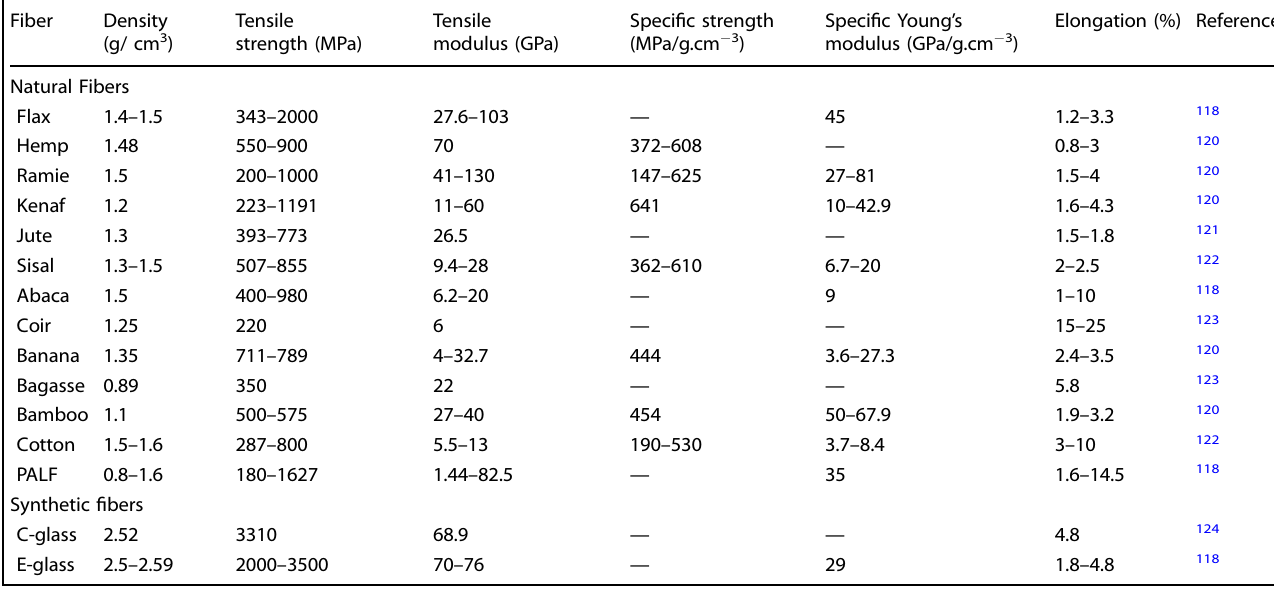
Table 3. Some common natural and synthetic fi bers ’ physical and